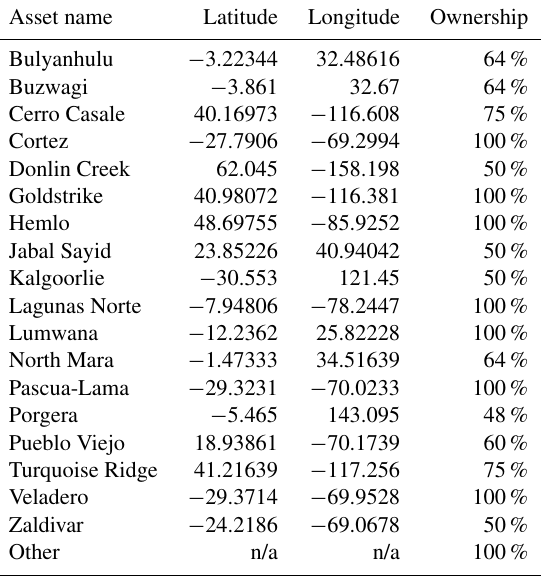
Table A5. Mining assets valued in TD Securities (2016a) for Barrick Gold.